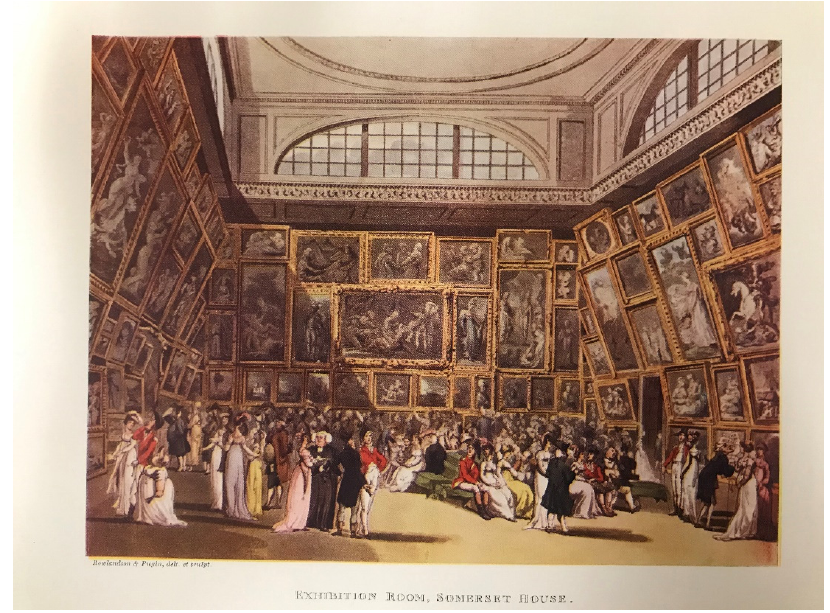
Figure 3. Thomas Rowlandson and Augustus Charles Pugin, Exhibition Room, Somerset House, 1 January 1808 . Aquatint and etching, 194 mm × 259 mm, Royal Academy of Art. Engraved by John Hill. Published by Rudolph Ackermann in Microcosm of London , London: R. Ackermann, 1808–10, vol. I, pl. 2. Photographer Julie